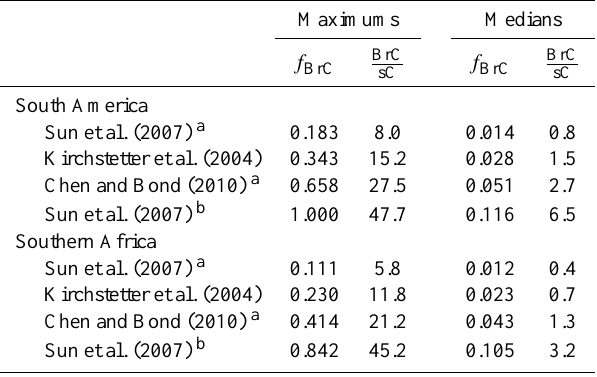
Table 4. Maximum and median BrC volume fractions, and BrC / sC mass ratios retrieved for fine mode aerosols at the biomass burning sites during the peak of the burning seasons (August–September for South America, July–September for southern Africa), using dif- ferent BrC refractive indices. The refractive index used for sC is m sC = 1 . 95 + 0 . 79 i